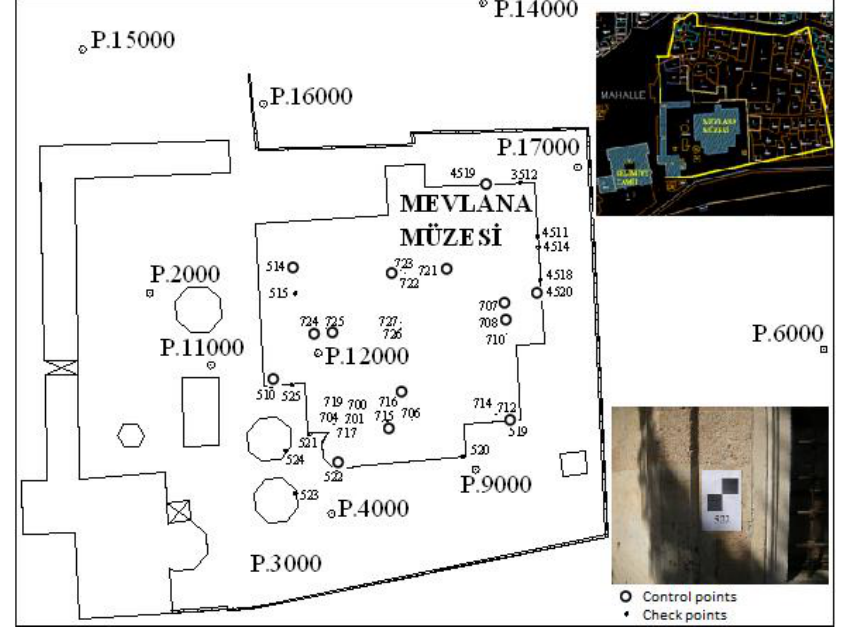
Figure 11. Control points were measured from traverse points. Georeferencing of the inside and outside point cloud models were executed by ground control points. The accuracy of the georeferencing was assessed by check points.